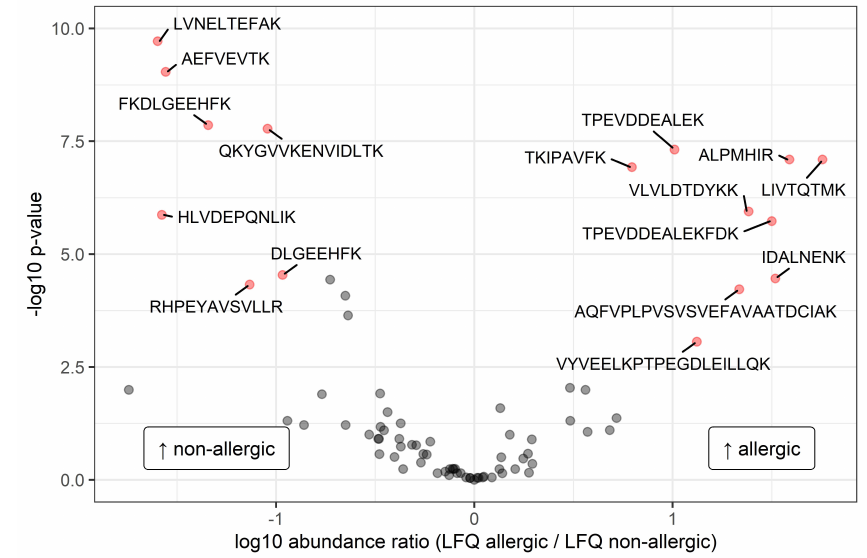
Figure 2. Volcano plot with the ratios of the group means of the 10 log transformed label-free quantification (LFQ) intensities of the identified peptide sequences. Significantly different peptides (false discovery rate < 0.01 and difference between groups > ± 0.75) are represented by filled red circles and labelled with the corresponding amino acid sequence. On the right side of the plot, the peptides with a higher level in allergic mothers are presented, and on the left side, the peptides with a higher level in nonallergic mothers are presented.